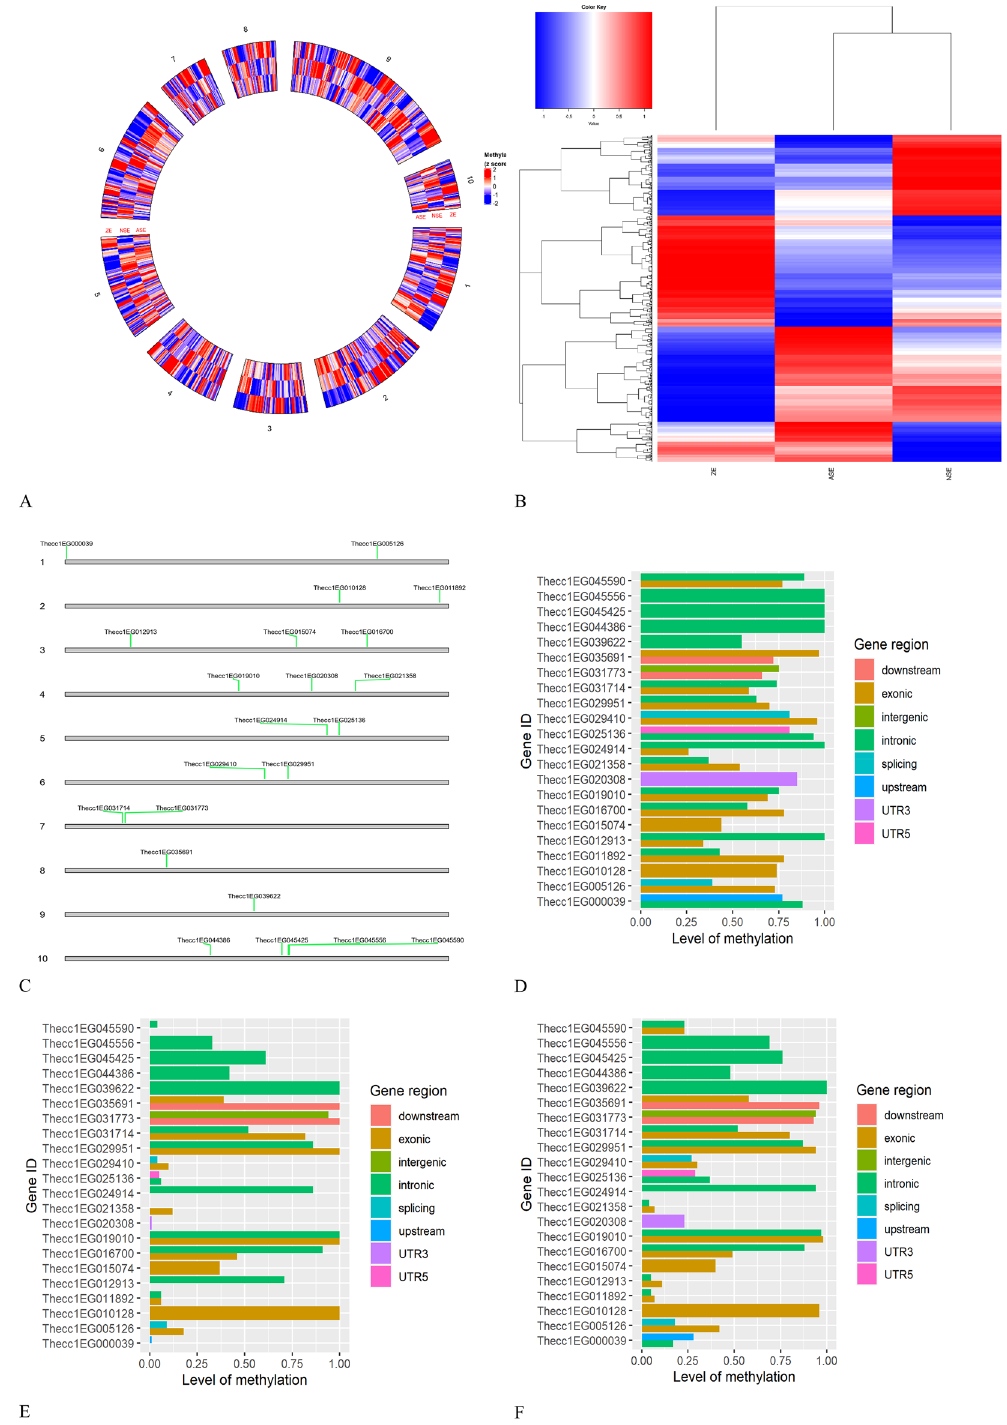
Figure 8. Genes differentially methylated related with SE abnormalities. ( A ) Circular heatmap showing differentially methylated regions in ZE, normal and abnormal SE ( ASE abnormal SE, NSE normal SE) across of ten chromosomes (873 genes). ( B ) Hierarchical heatmap grouping the differentially methylated genes related with similarities between ZE, normal and abnormal SE where 4 groups were formed. For ZE and abnormal SE there were more genes with similar methylation levels, normal SE present high differences when is compare with ZE. ( C ) Gene differentially methylated distribution across of ten chromosomes with important functions in stress response, defense response, auxin transport, cell polarity, PCD, cell wall biogenesis, and embryo shoot and root development. Gene regions differentially methylated between ZE ( D ), normal SE ( E ) and abnormal SE ( F ) with important functions in stress response, defense response, auxin transport, cell polarity, PCD, cell wall biogenesis, and embryo shoot and root development. Color code blue (hypomethylation), white (unmethylated) and red (hypermethylation) in A and B. Protein, chromosome position and function of genes with code (gene ID) are presented in the Table 2. NSE normal SE and ASE abnormal SE in figures ( A,B